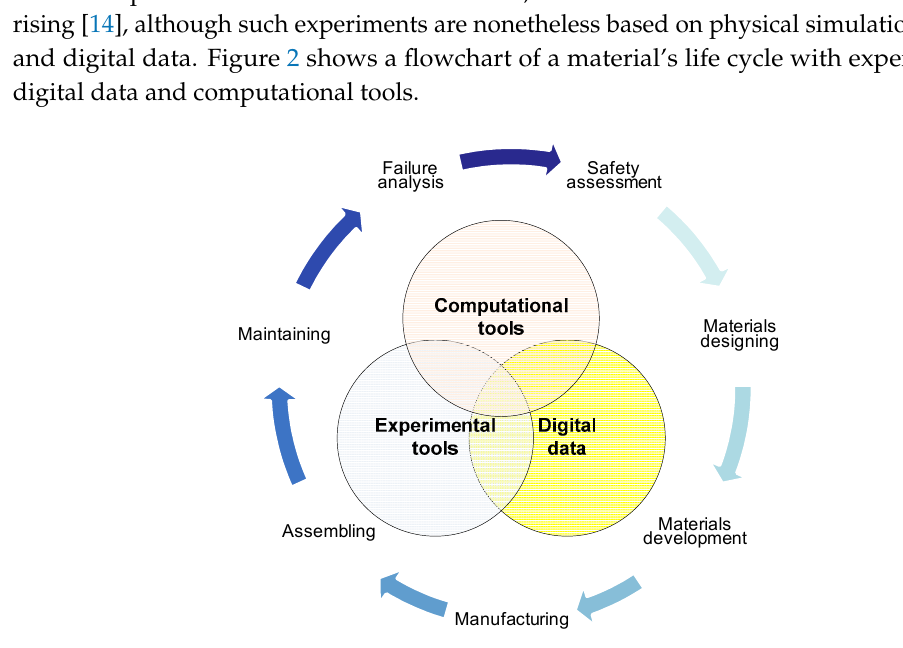
Figure 2. Flowchart of a material’s life cycle with experimental tools, digital data and computational tools.